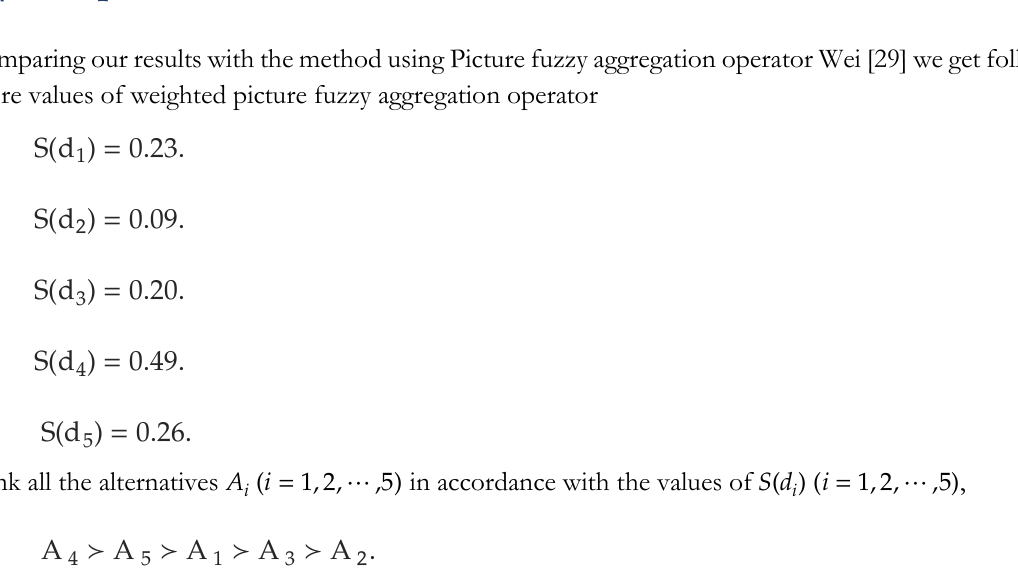
Table 4. Ranking all the alternatives 𝐀